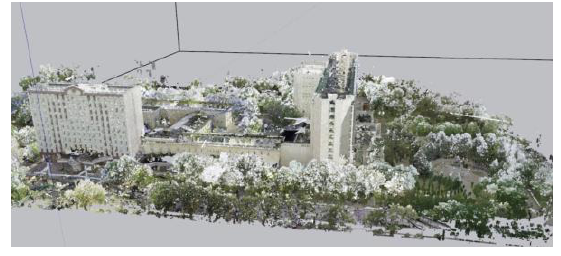
Figure 2. Satbayev University point cloud.